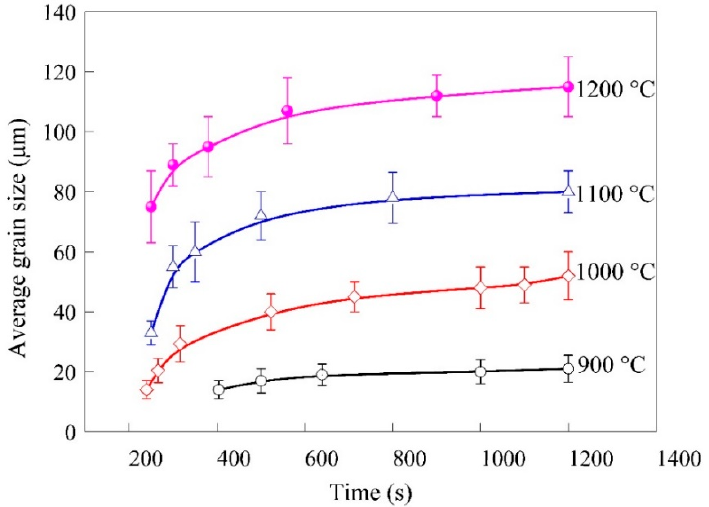
Figure 6. The grain size evolutions during holding for 1200 s.